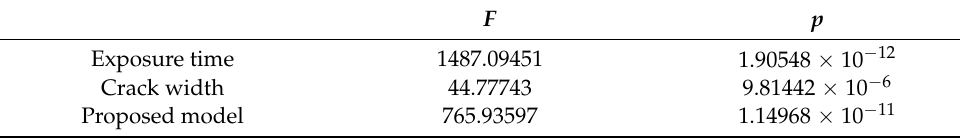
Table 5. F-test results of the model of apparent chloride diffusion coefficient.